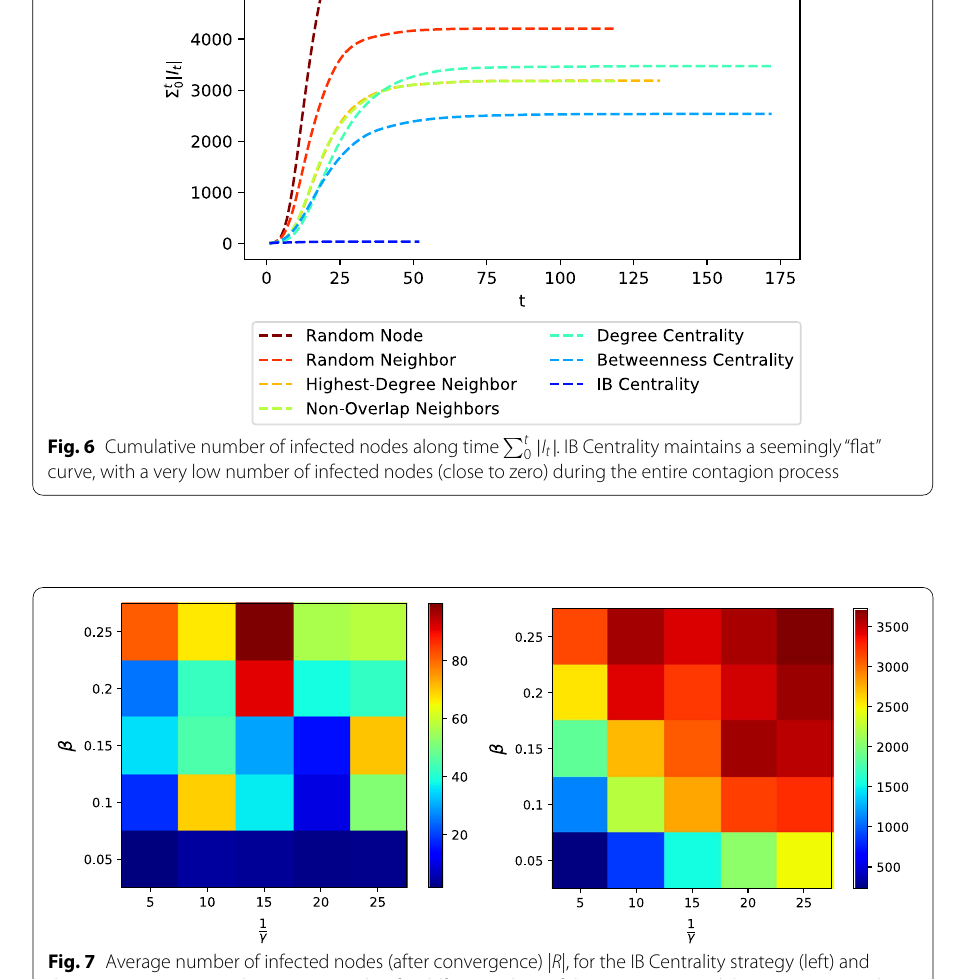
Fig. 7 Average number of infected nodes (after convergence) | R |, for the IB Centrality strategy (left) and the Betweenness Centrality strategy (right), for different values of the contagion model parameters β and γ . IB Centrality obtains | R | values that are considerably lower than those of Betweenness Centrality for all considered values of β and